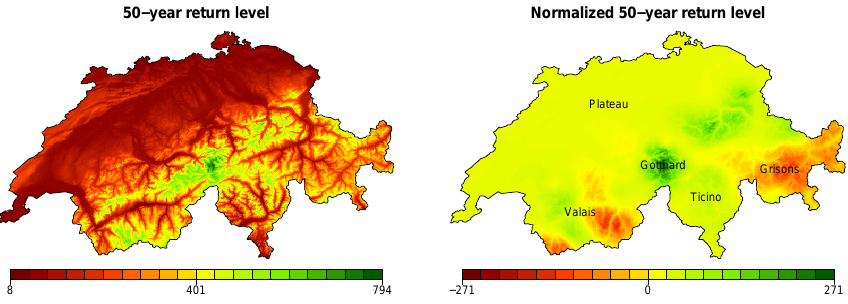
Fig. 8. 50-year return level map (left panel) and regional variability after removing the altitudinal effect (right panel) with the smooth GEV model. Units are centimeters.